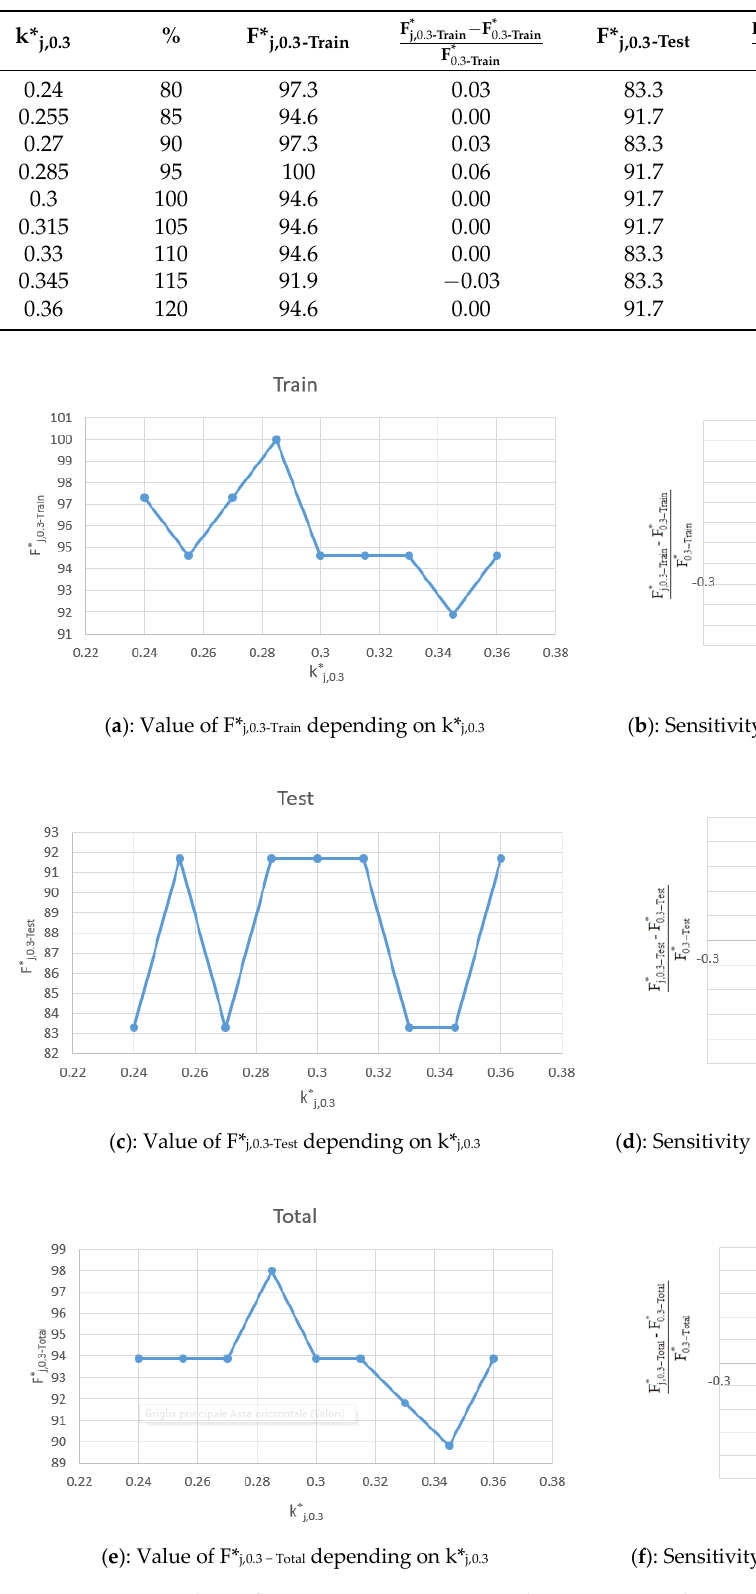
Figure 9. Values of F* j,0.30 − Train , F* j,0.30 − Test, and F* j, 0.30 − Total and sensitivity function for the scenario with k* 0.30 .